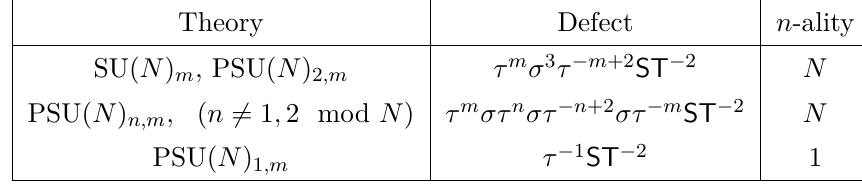
Table 18 . (Non-)invertible symmetries of su ( N ) with N being a prime integer at τ YM = 1 . Open